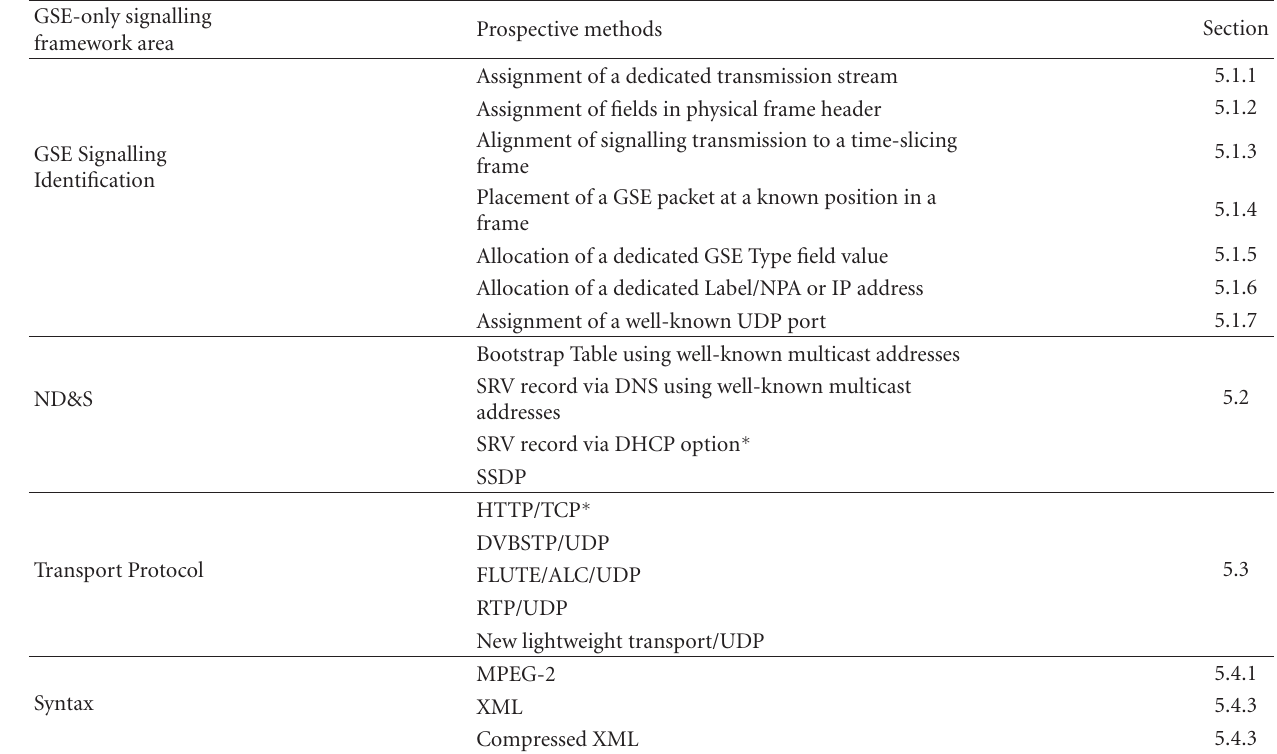
Table 3: Potential methods for a GSE-only signalling